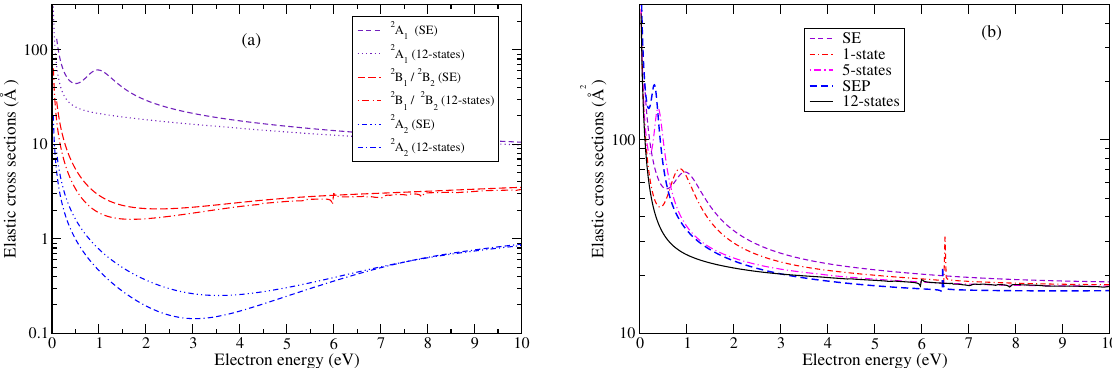
Figure 3. ( a ) Symmetry wise elastic cross sections in the SE and the 12-states CC model. ( b ) Elas- tic cross sections obtained in different scattering models to highlight the effect of polarisation on scattering. These results do not include the long-range